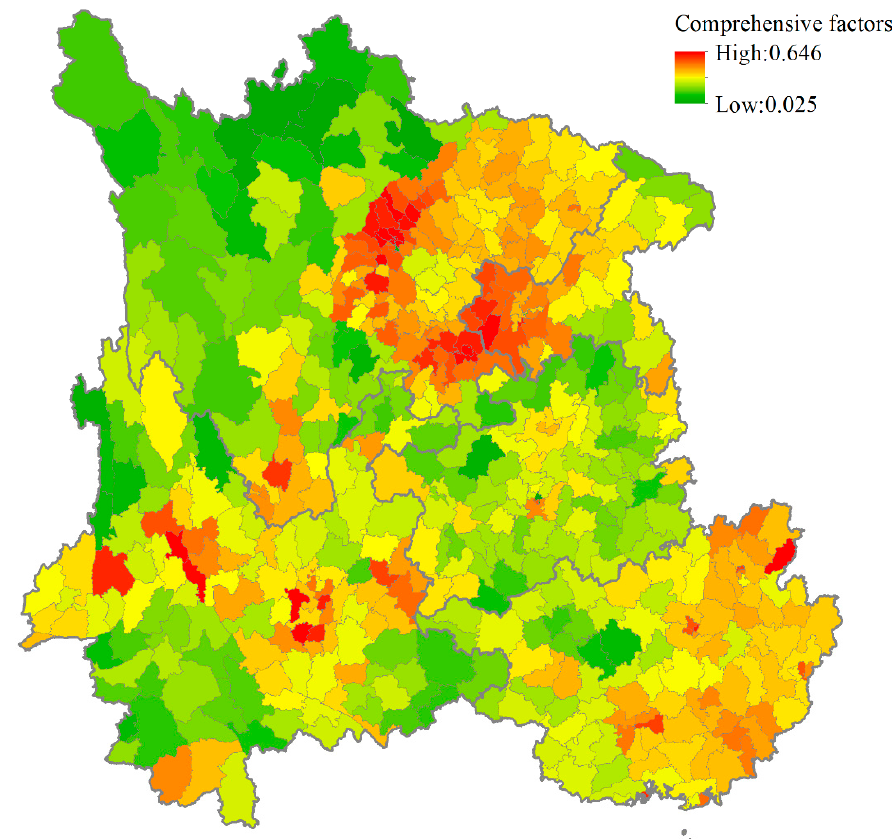
Figure 6. The spatial distribution of comprehensive water demand elements at the county level.